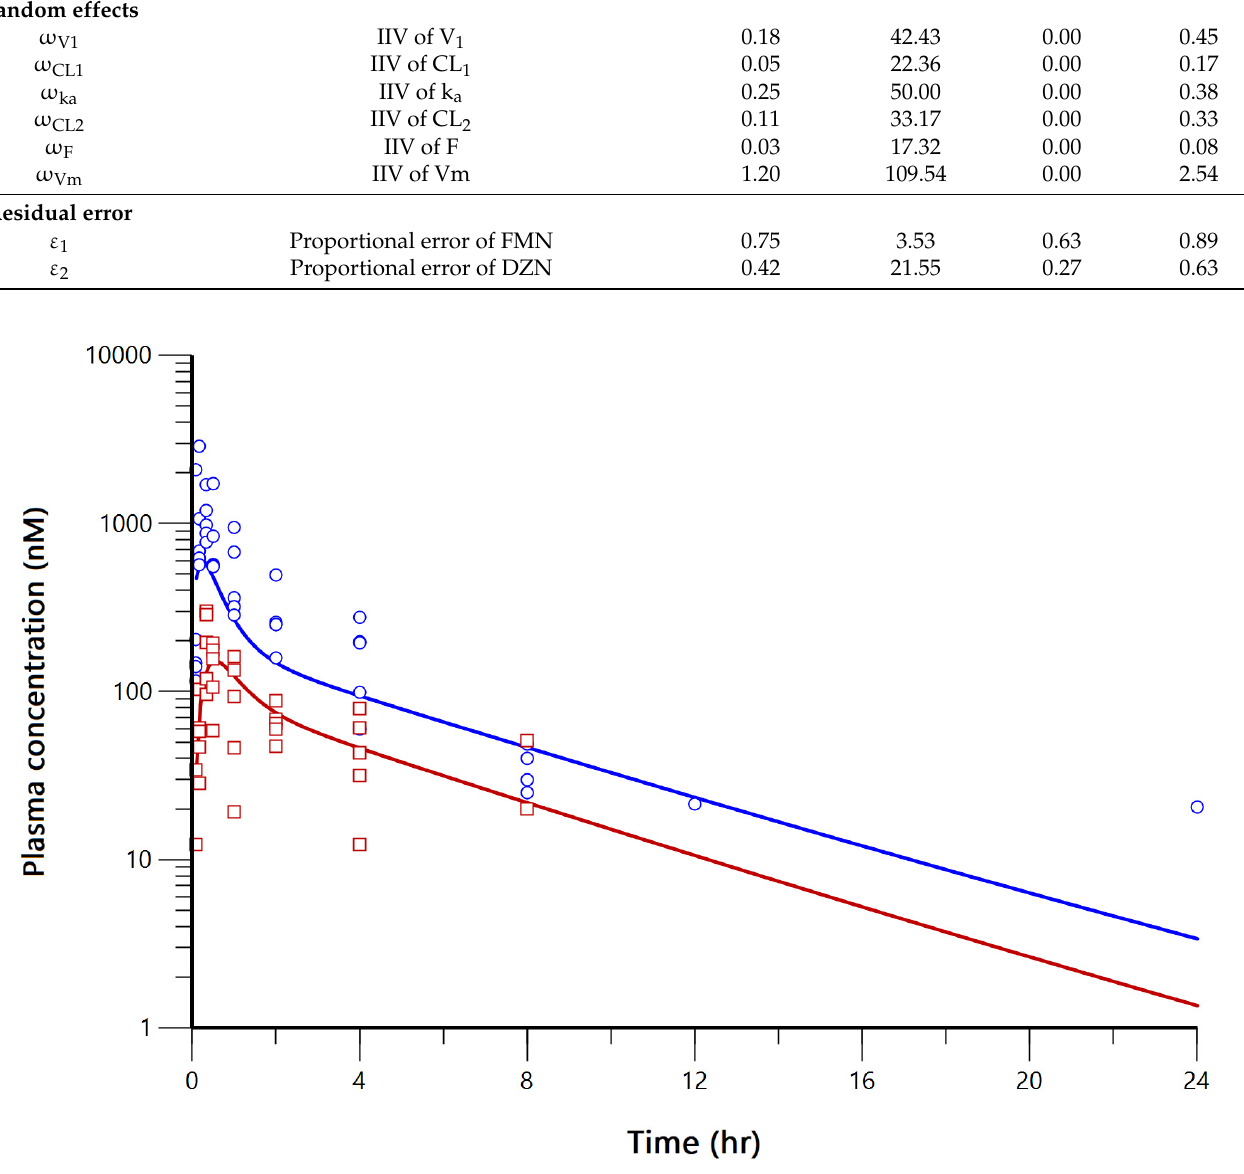
Figure 7. Observed and predicted plasma concentration-time plot of FMN (observed: ○ , predicted: straight blue line) and DZN (observed: □ , predicted: straight red line) of FMN solid dispersion oral administration group.